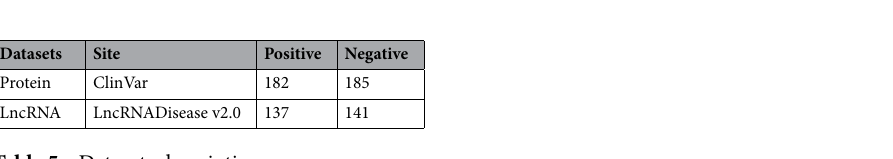
Table 5. Datasets